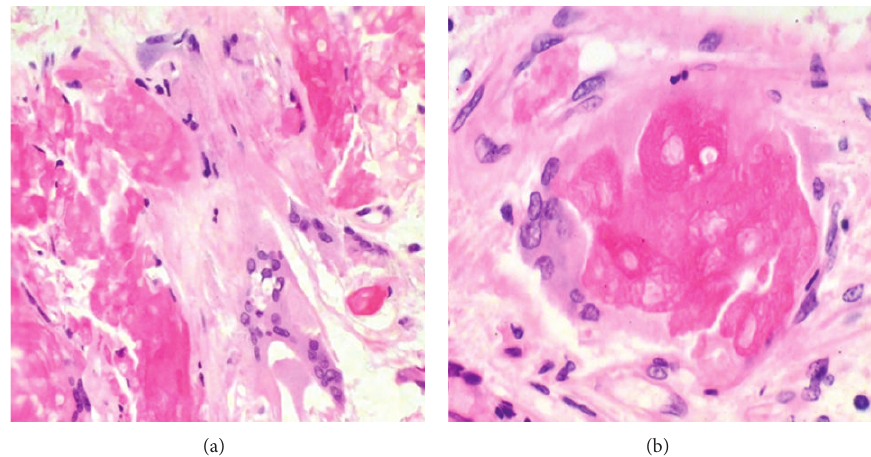
Figure 5: Foreign body giant cell reaction to the keratin (H&E, × 400 (a) and × 600